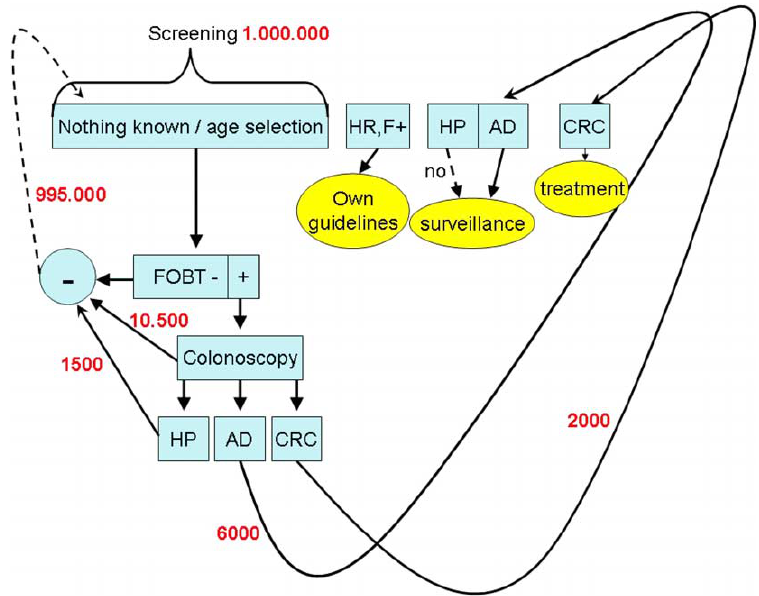
Fig. 1. Approximate cohort composition for 1 million individuals. Abbreviations in the figure: HR = high risk; F + = positive family history; CRC = colorectal cancer; HP = hyperplastic polyp; AD = adenoma. Numbers are approximates taken from European